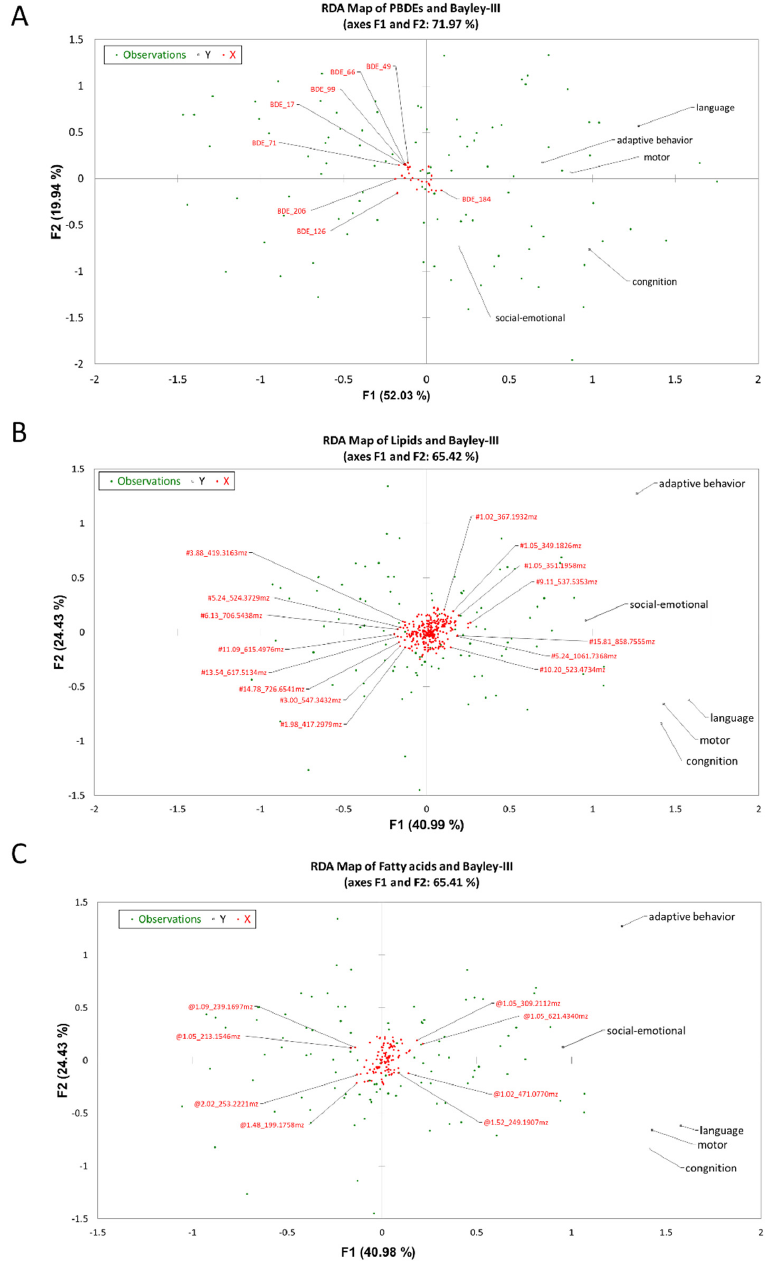
Figure 2. Redundancy analysis (RDA map) of PBDEs, lipids, fatty acids, and Bayley-III scores. ( A ) The canonical correlation between PBDEs and the five domains of Bayley-III. ( B ) The canonical correlation between lipids and the five domains of Bayley-III. ( C ) The canonical correlation between fatty acids and the five domains of Bayley-III. 3.6. Multivariate Analyses of HBM PBDEs, Lipids, Fatty Acids, and Bayley-III Scores From 30 PBDEs, Σ 30PBDEs, 292 lipids, and 109 fatty acids, we identified four PBDEs, 54 lipids, and 45 fatty acids that were significantly correlated with the five domains of